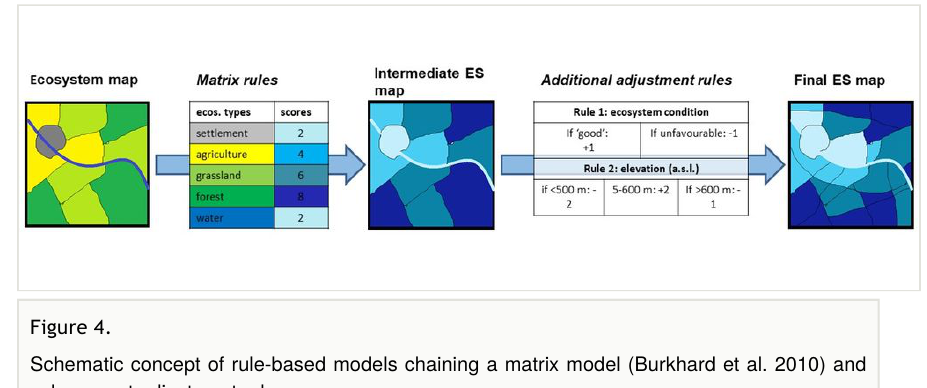
Schematic concept of rule-based models chaining a matrix model (Burkhard et al. 2010) and subsequent adjustment